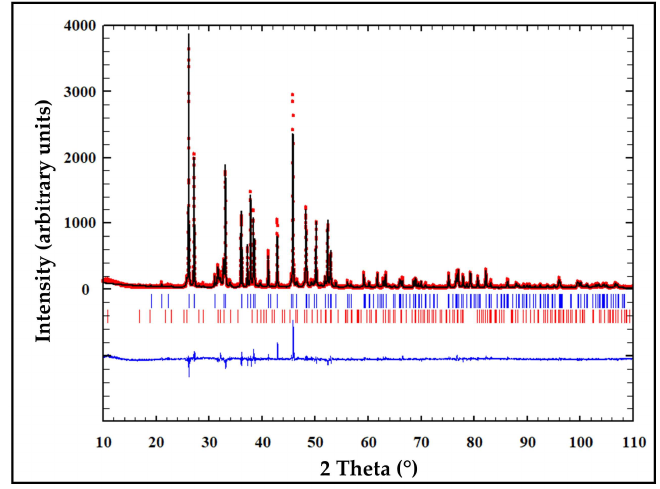
Figure A2. Exemplary Rietveld refinement plot for Porites sp. after conversion for one week. Red dots: data points, black line: calculated XRD profile, bottom blue line: difference of observed and calculated data, blue vertical bars: positions of aragonite diffraction peaks, red vertical bars: position of apatite diffraction peaks.